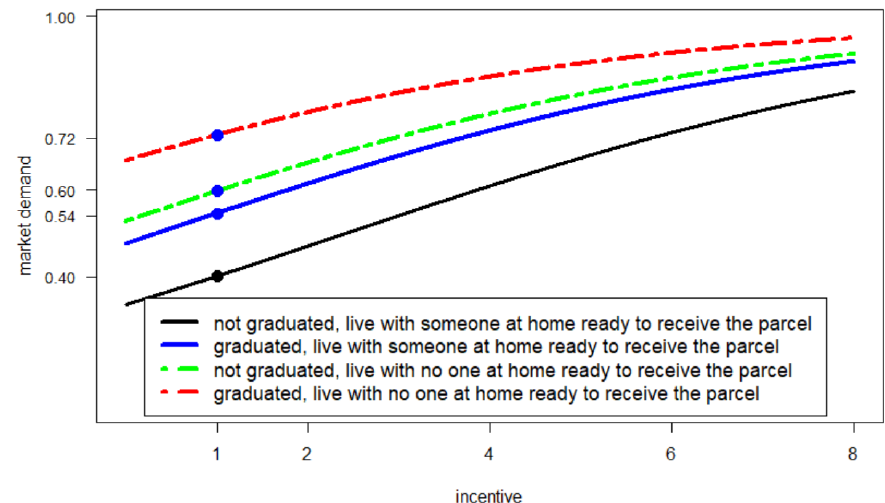
Figure 1. Base scenario–demand–incentive curve.